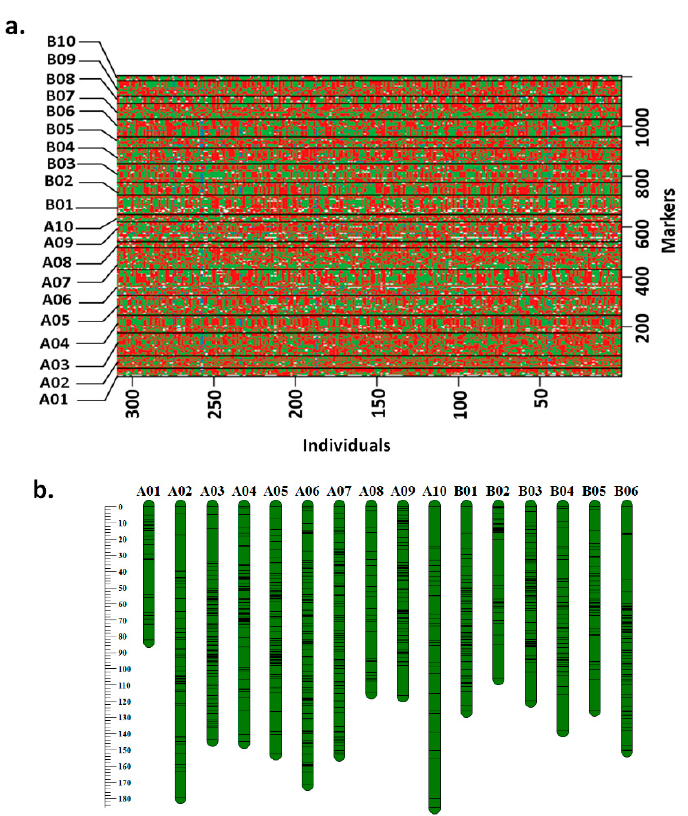
Figure 1. A refined genetic map comprising 1205 loci for TAG 24 × ICGV 86031 RIL population: ( a ) recombination break- points between TAG 24 and ICGV 86031; ( b ) map chart of 20 chromosomes.